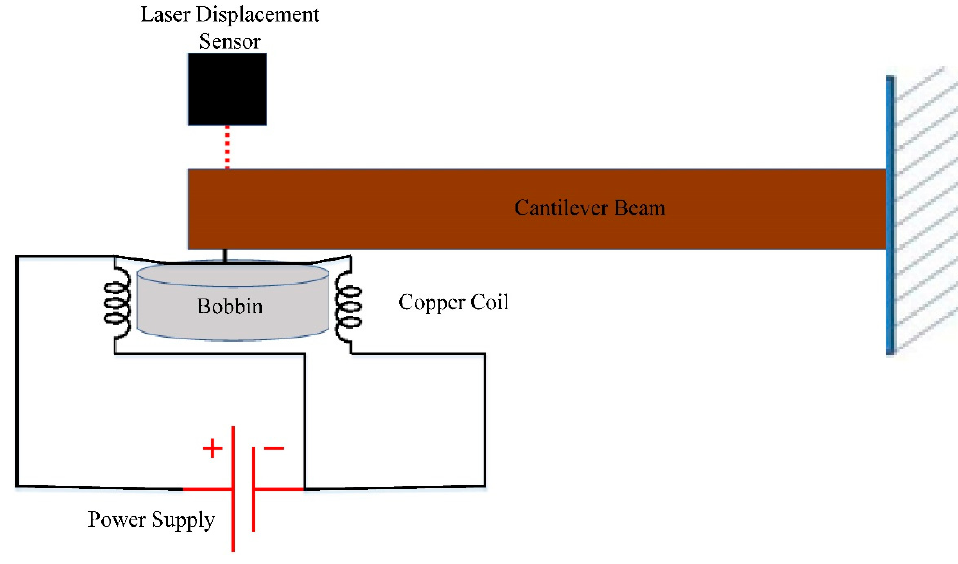
Figure 7. Schematic diagram of VCA.